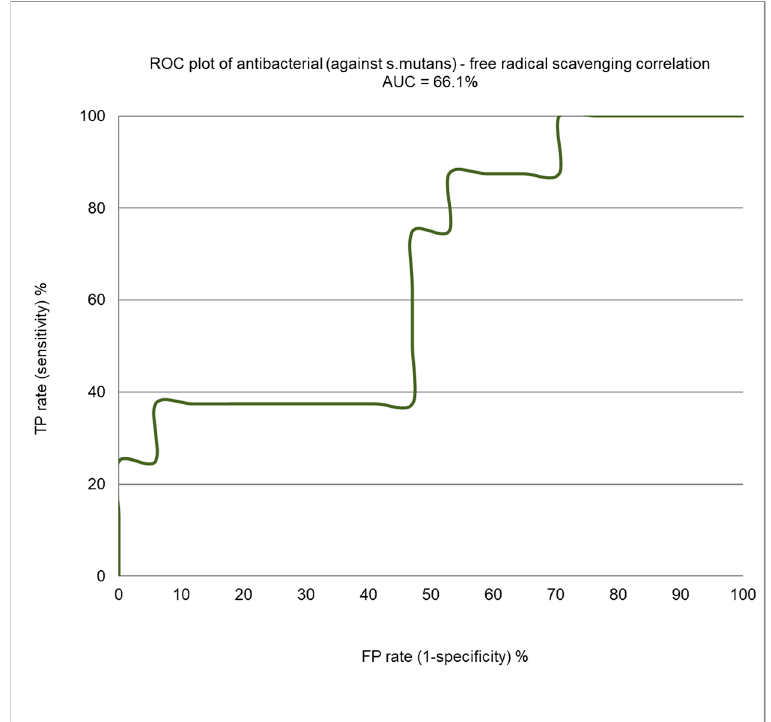
Figure 4. A receiver operating characteristic (ROC) curve showing the performance of the antibacterial/free radical scavenging correlation model.